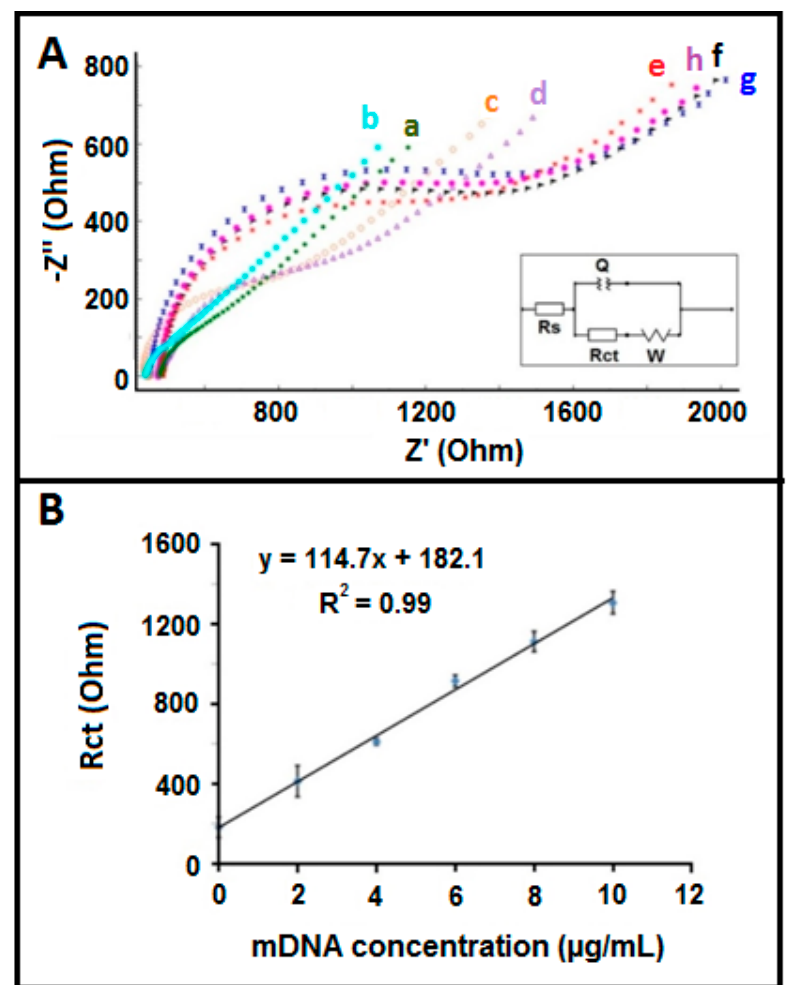
Figure 4. ( A ) Nyquist diagrams obtained by (a) CNF-SPE, (b) after the pseudo hybridization of ZNA probe, after the hybridization between ZNA probe and mDNA target in the concentration level of (c) 2, (d) 4, (e) 6, (f) 8, (g) 10, (h) 12 µg/mL. ( B ) Calibration graph based on the average R ct values ( n = 3) obtained after the hybridization of 1 µg/mL ZNA probe with mDNA target in the concentration range from 2 to 10 µg/mL.